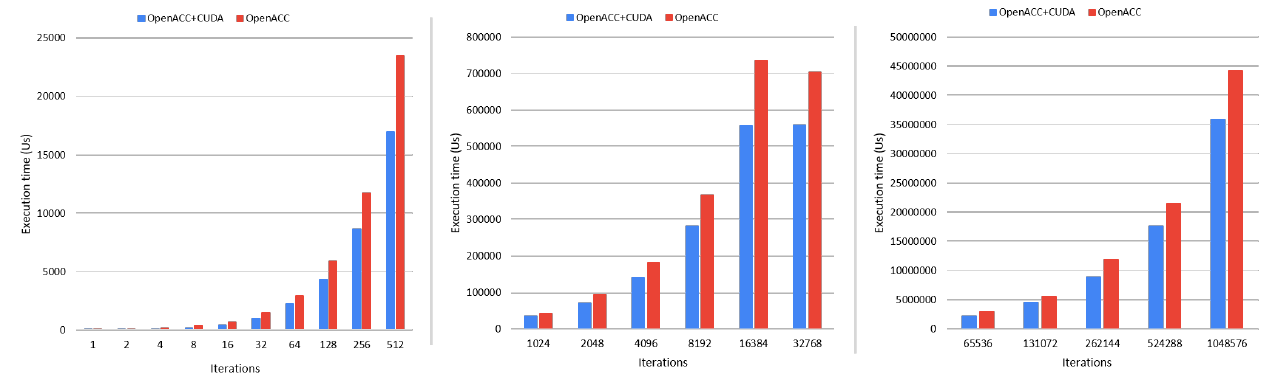
Figure 5. Execution time ( µ s) increasing the number of iterations and keeping constant the size of the population (1024